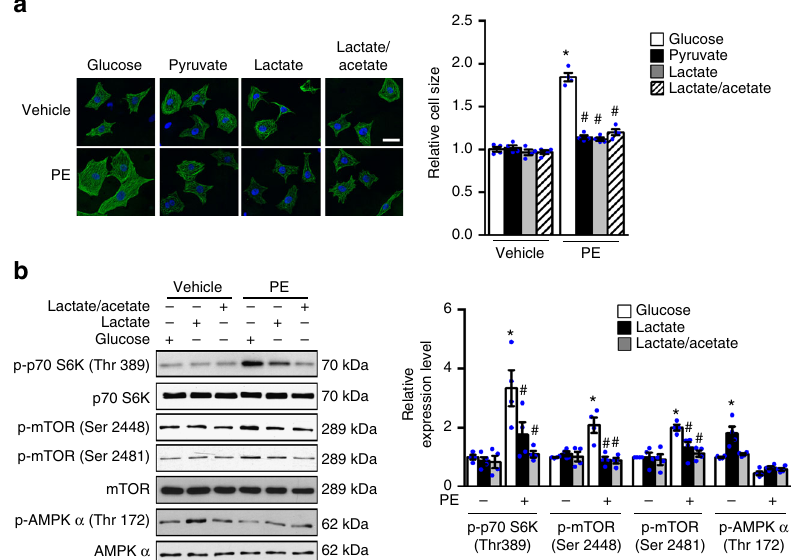
Fig. 5 Glucose removal inhibits mTOR activation and cell growth. a NRCMs were pretreated with DMEM containing either glucose or non-glucose substrates for one hour and then incubated with phenylephrine (PE, 100 μ M) or vehicle for 48 h. Myocytes were fi xed and stained with anti-Troponin T to visualize CMs. Cellular surface area in each group was quanti fi ed and expressed relative to the control (* p < 0.05 vs. Glucose/Vehicle, # p < 0.05 vs. Glucose/PE, n = 4). Scale bar, 25 μ m. b NRCMs were pretreated with DMEM containing either glucose or non-glucose substrates for one hour and then incubated with phenylephrine (PE, 100 μ M) or vehicle for 6 h. Immunoblots of cell lysates (left) and statistical analyses of densitomeric measurements of p-p70 S6K (Thr 389), p-mTOR (Ser 2448), p-mTOR (Ser 2481), and p-AMPK α (Thr 172) (right) are shown (* p < 0.05 vs. Glucose/PE(-), # p < 0.05 vs. Glucose/PE( + ), n = 4). Data shown as mean ± s.e.m. P values were determined using one-way ANOVA followed by Newman – Keuls comparison test ( b ) or Kruskal-Wallis test followed by Dunn ’ s comparison test ( a